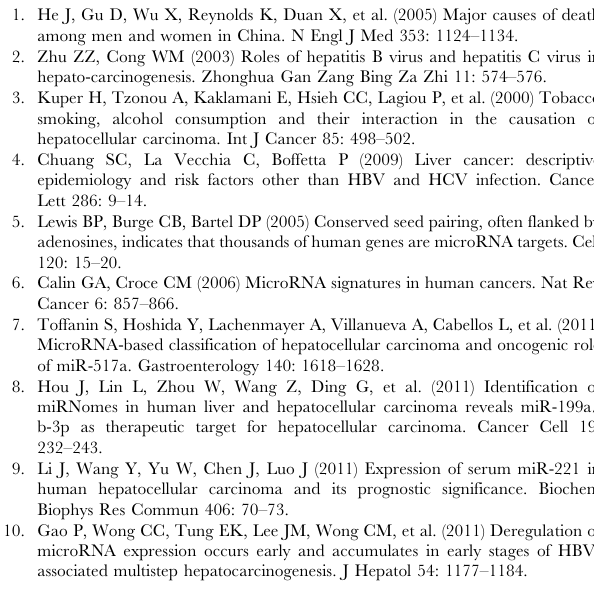
Table S1 Stratified analyses on association between rs999885 and risk of HCC and HBV persistent infection. NOTE: Multivariate logistic regression analyses adjusted for age, sex, smoking status and drinking status in dominant genetic model (excluded the stratified factor in each stratum). a HCC patients